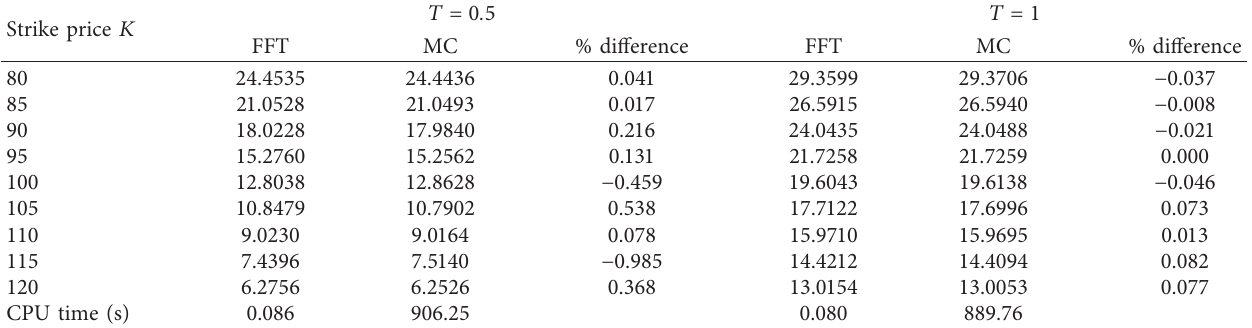
Table 2: Option prices using FFT and MC methods.